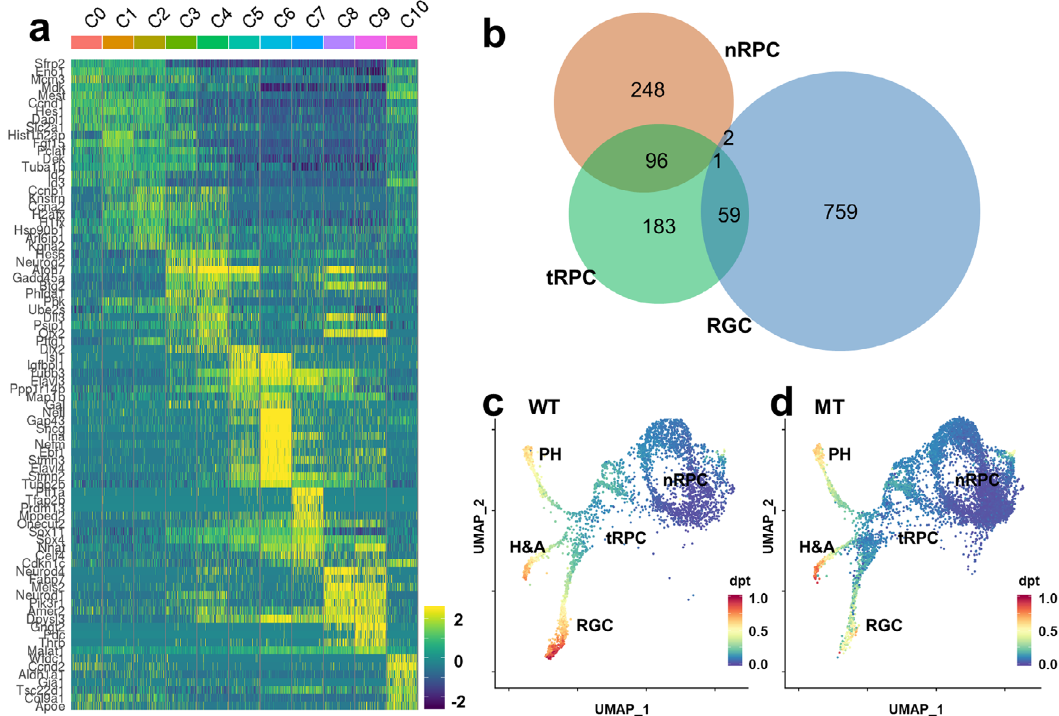
Fig. 4 Cluster-speci fi c gene expression reveals the relationships among the wild-type clusters. a A heatmap showing the top ten enriched genes in each cluster. Each horizontal line represents one gene and each vertical line represents one cell. Data from equal numbers (100) of cells from each cluster are shown. The heatmap demonstrates the continuity and directionality between these clusters. The color scale represents relative expression levels which were generated by averaging the normalized gene expression values in each cluster and then centering and scaling the values in each row using R bioconductor package “ pheatmap ” (see “ Methods ” ). b A Venn diagram showing the overlaps of enriched genes between naive RPCs (nRPC, C0 – C2), transitional RPCs (tRPC, C3 and C4), and retinal ganglion cells (RGCs, C5 and C6). tRPCs have substantial overlaps with both nRPCs and RGCs, but nRPCs and RGCs have very few overlapped genes, indicating the unidirectional relationship of these clusters. Source data are provided in Supplementary Data 4. c , d Developmental trajectories predicted by the SCANPY tool based on diffusion pseudotime (DPT), which measures transitions between cells (see “ Methods ” for details). The color scales represent estimated DPTs for individual cells, where 0 is the start pseudotime, and 1 is the end pseudotime. Three trajectories representing the emergence of photoreceptors (PH), horizontal and amacrine cells (H&A), and RGCs from RPCs are identi fi ed for both the wild-type (WT) ( c ) and Atoh7 -null (MT) ( d ) cells. The direction of each lineage is clearly discernible, although the RGC lineage of the MT cells does not advance as far as the WT